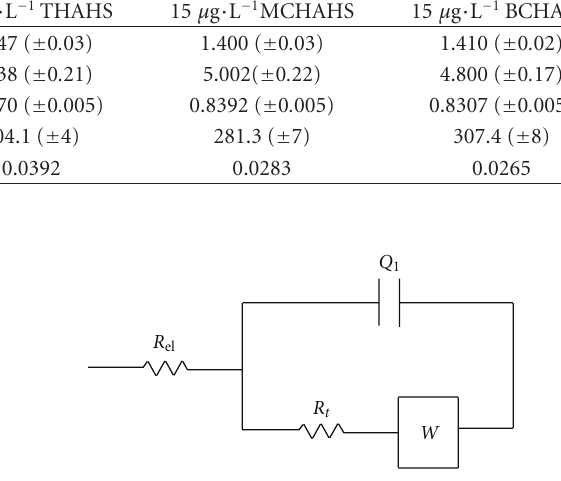
Figure 8: Proposed equivalent circuit used for fitting of the impedance